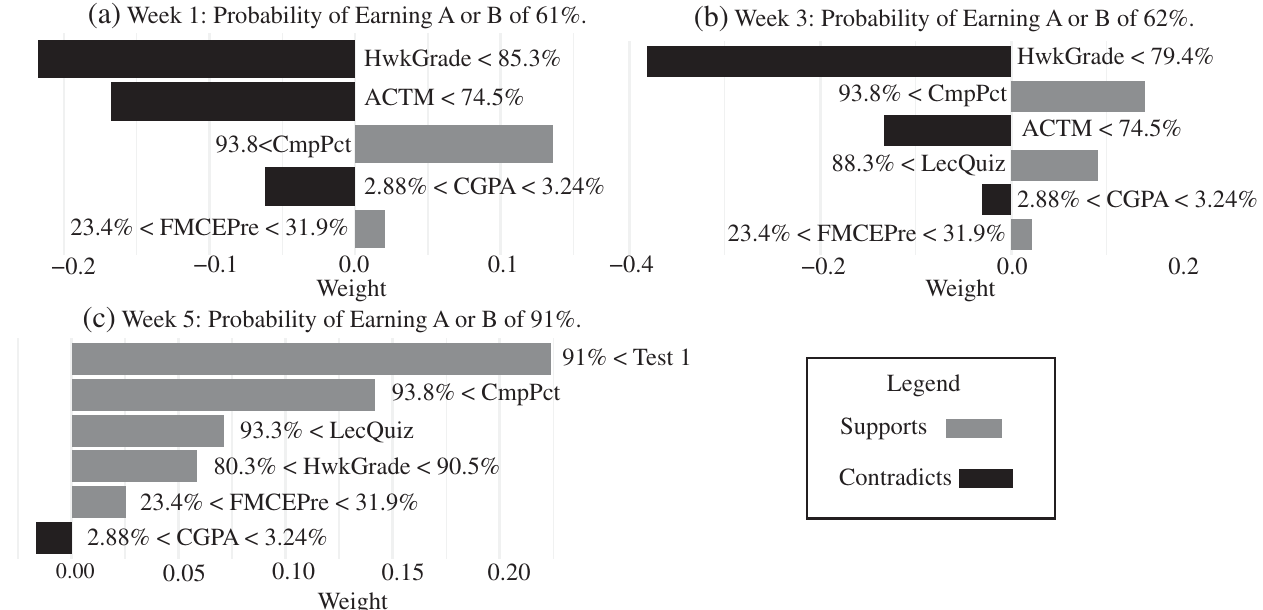
FIG. 5. Physics 1 LIME results for one student for week 1, week 3, and week 5. The student received a B in the